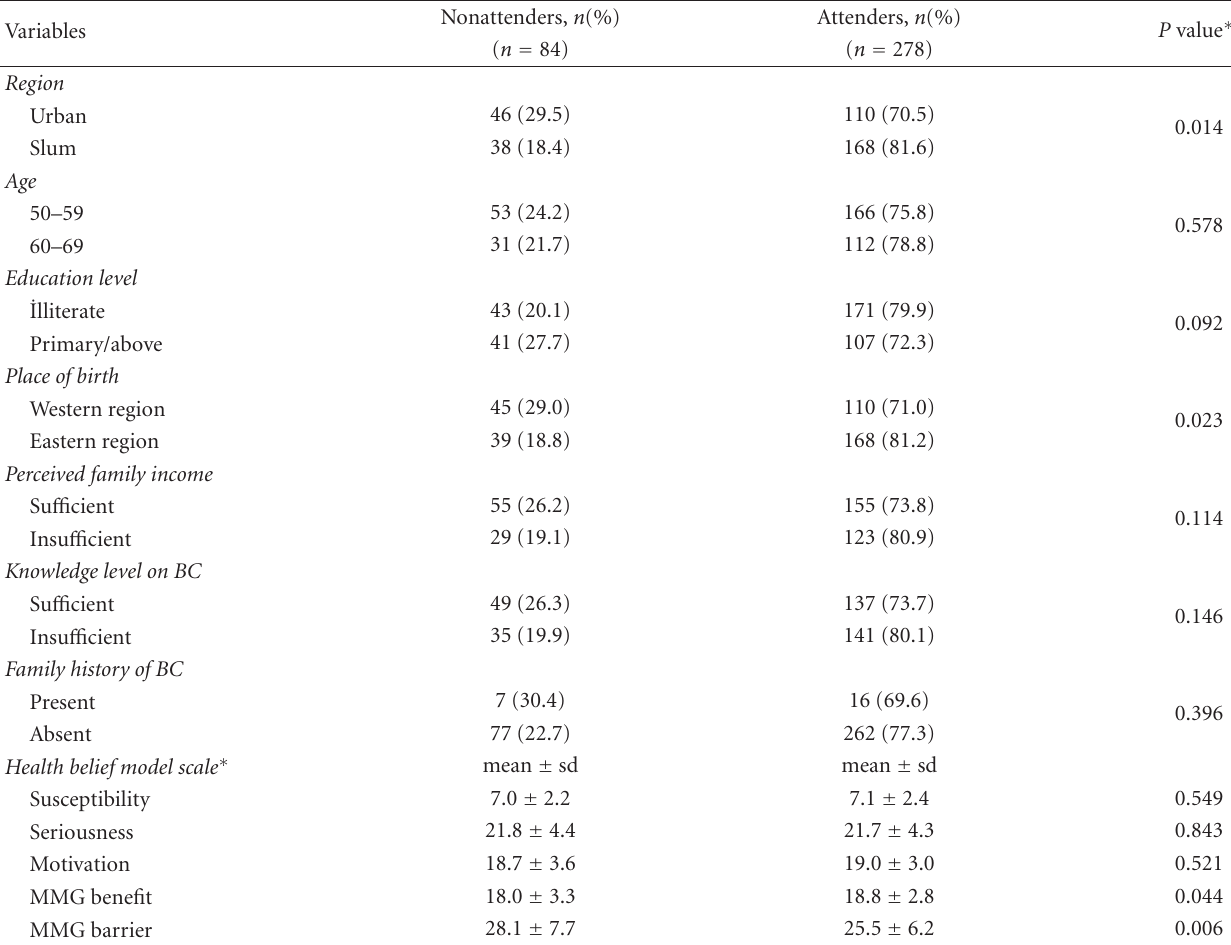
Table 2: Sociodemographic characteristics, knowledge level, family history of BC, and health beliefs of attenders and nonattenders to mammography screening